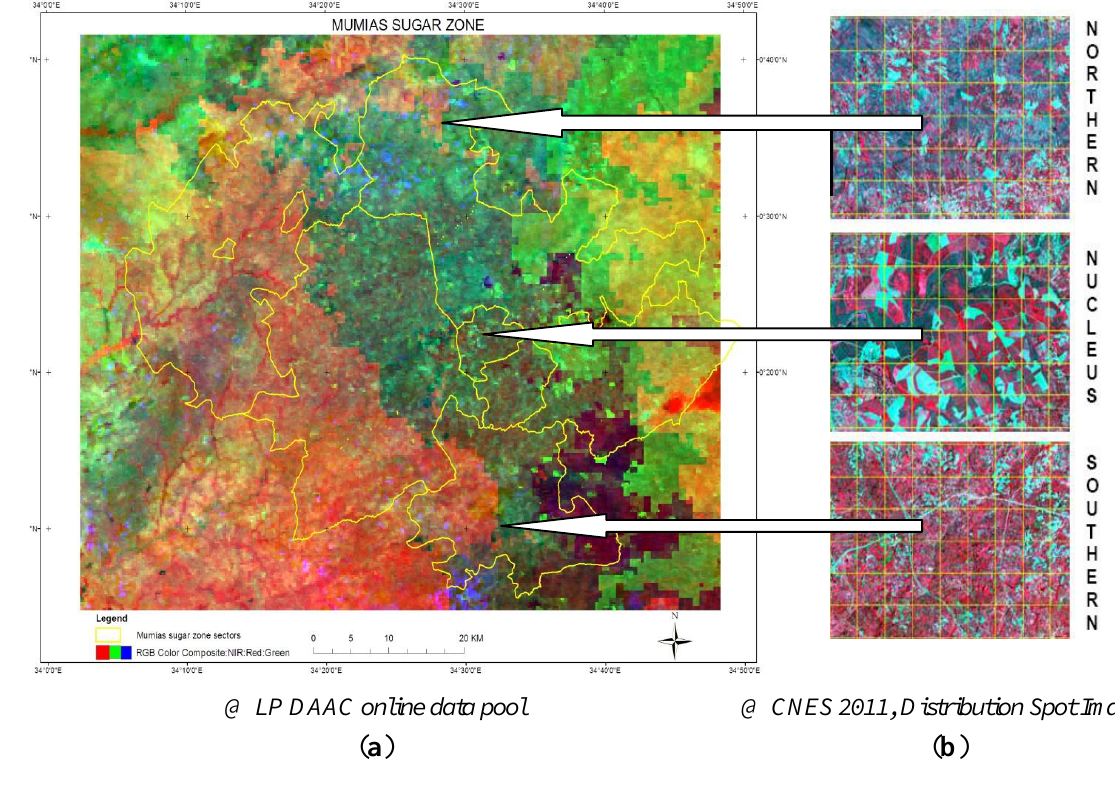
Figure 2. ( a ) MODIS 250 m color composition of Mumias zone (sectors within the zone are delineated by a yellow line), and ( b ) subsets of a December 2011 SPOT 2.5 m image on three sectors; the overlaying yellow grids correspond to the 250 m spatial resolution of MODIS